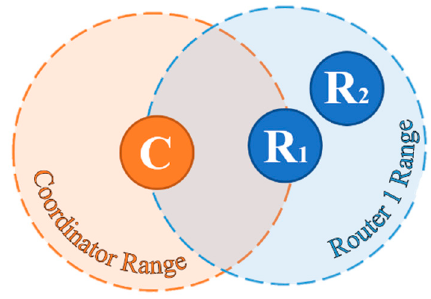
Figure 14. Representation of Case A.5.